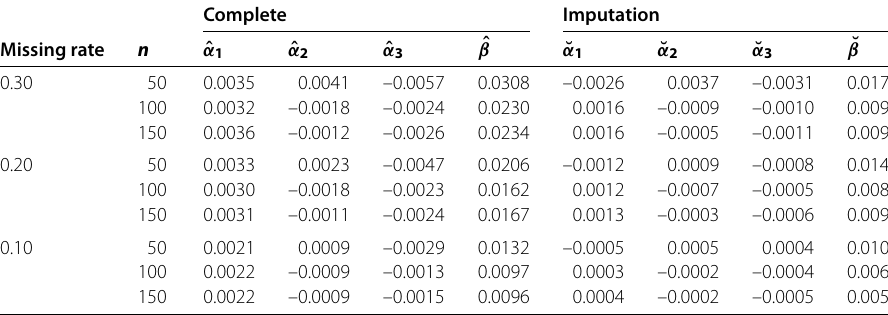
Table 1 Biases of α and β under different missing functions and different sample sizes obtained by two different methods for the simulated data Complete Imputation